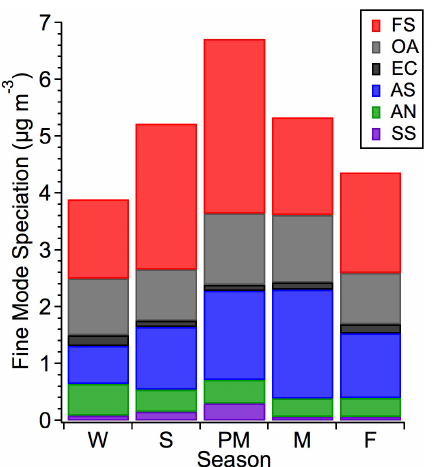
Figure 2. Seasonal PM 2 . 5 speciation from the averaged Saguaro National Park and Saguaro West IMPROVE sites. Six major group- ings comprising the PM 2 . 5 mass are shown: FS (fine soil), OA (or- ganic aerosol), EC (elemental carbon), AS (ammonium sulfate), AN (ammonium nitrate) and SS (sea salt).